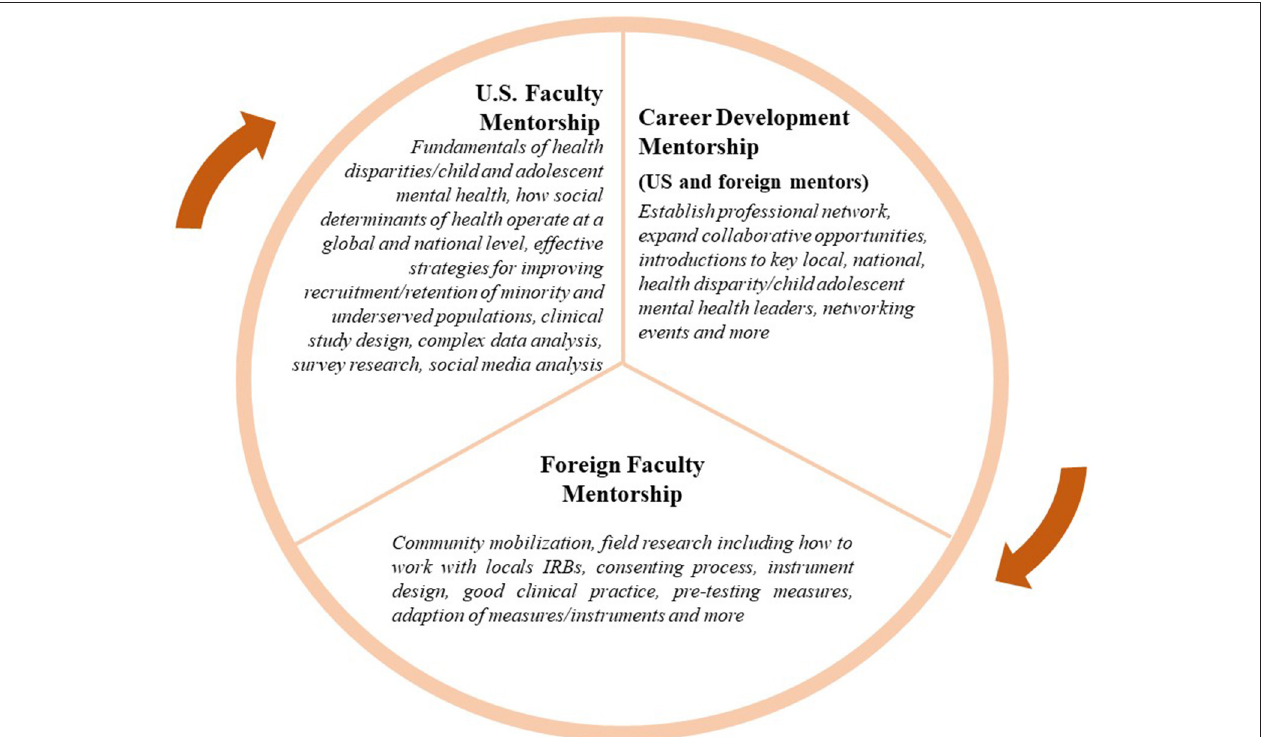
FIGURE 1 | LEAD Mentorship